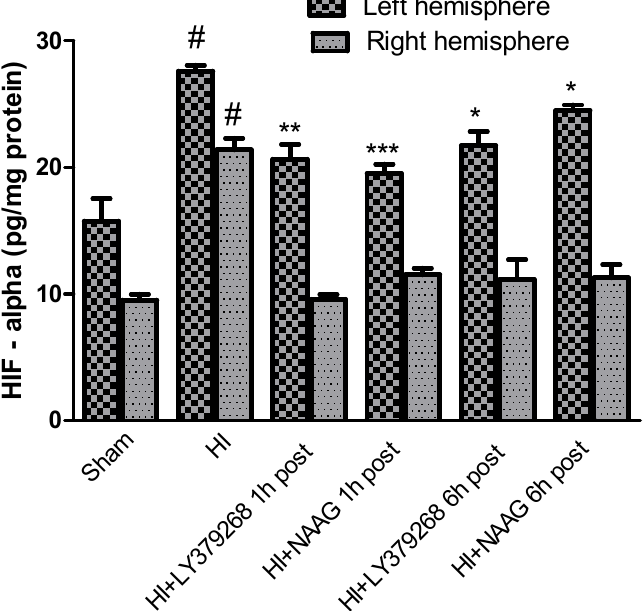
Figure 3. The effect of LY379268 or NAAG application 1 h or 6 h after HI on HIF-1α concentration. Results are presented as the mean ± SEM, n = 5; statistically significant differences: * p < 0.01; ** p < 0.005, *** p < 0.001—significantly different from the HI group; # p < 0.005 significantly different from the sham operated group.